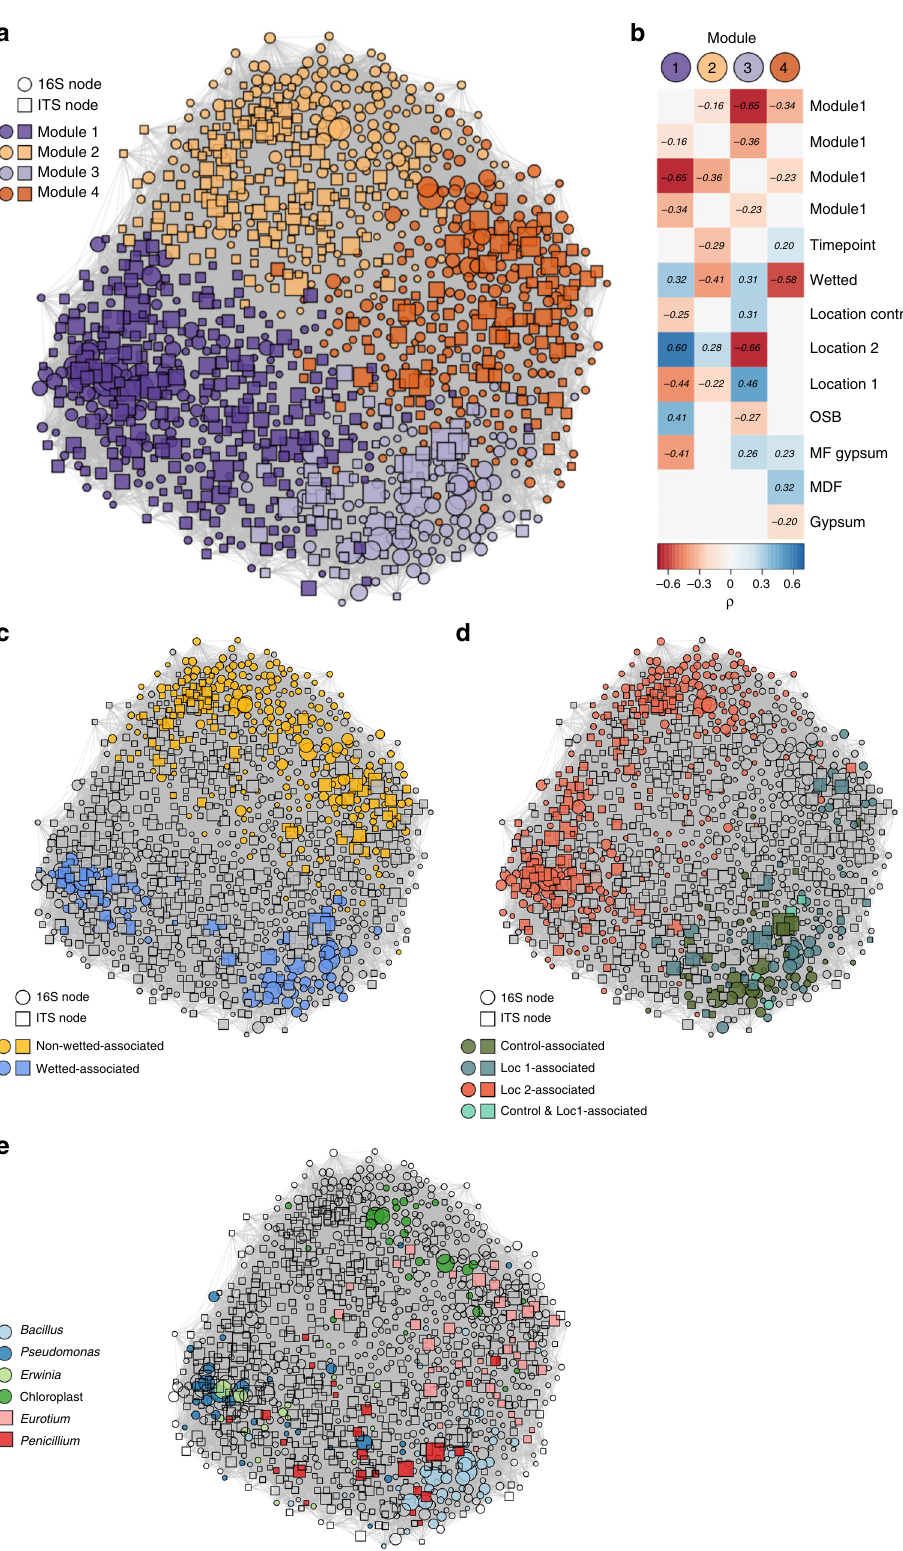
Fig. 5 Network of SparCC OTU correlations. a Edge-weighted, spring-embedded network ordination, with nodes colored by module membership. Node shape represents node type (16S or ITS) and node size is based on the log-transformed abundance of each node ( n = 153 with both 16S and ITS, respectively). b Correlations between metadata factors (treated as dummy variables where true = 1 and false = 0) and the percent of reads in network modules. Nonsigni fi cant correlations are not shown. c Taxa enriched in wet or nonwetted samples, as determined through a two-sided nonparametric t test with 10 5 permutations. d Taxa enriched in samples originating from an individual inoculating location, with statistical methods as in a . e Taxonomy of nodes in the genera included in Fig.